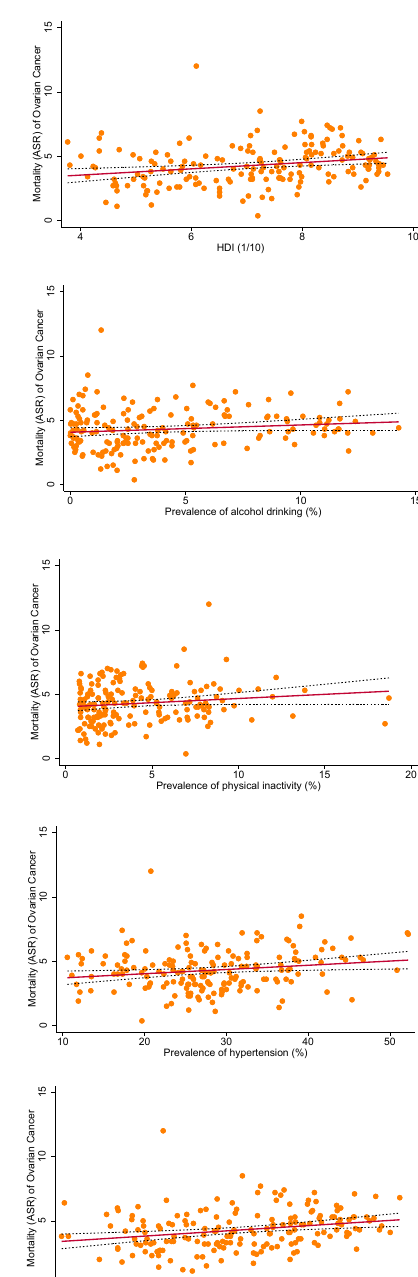
Figure 3 . Associations between risk factors and mortality of ovarian cancer